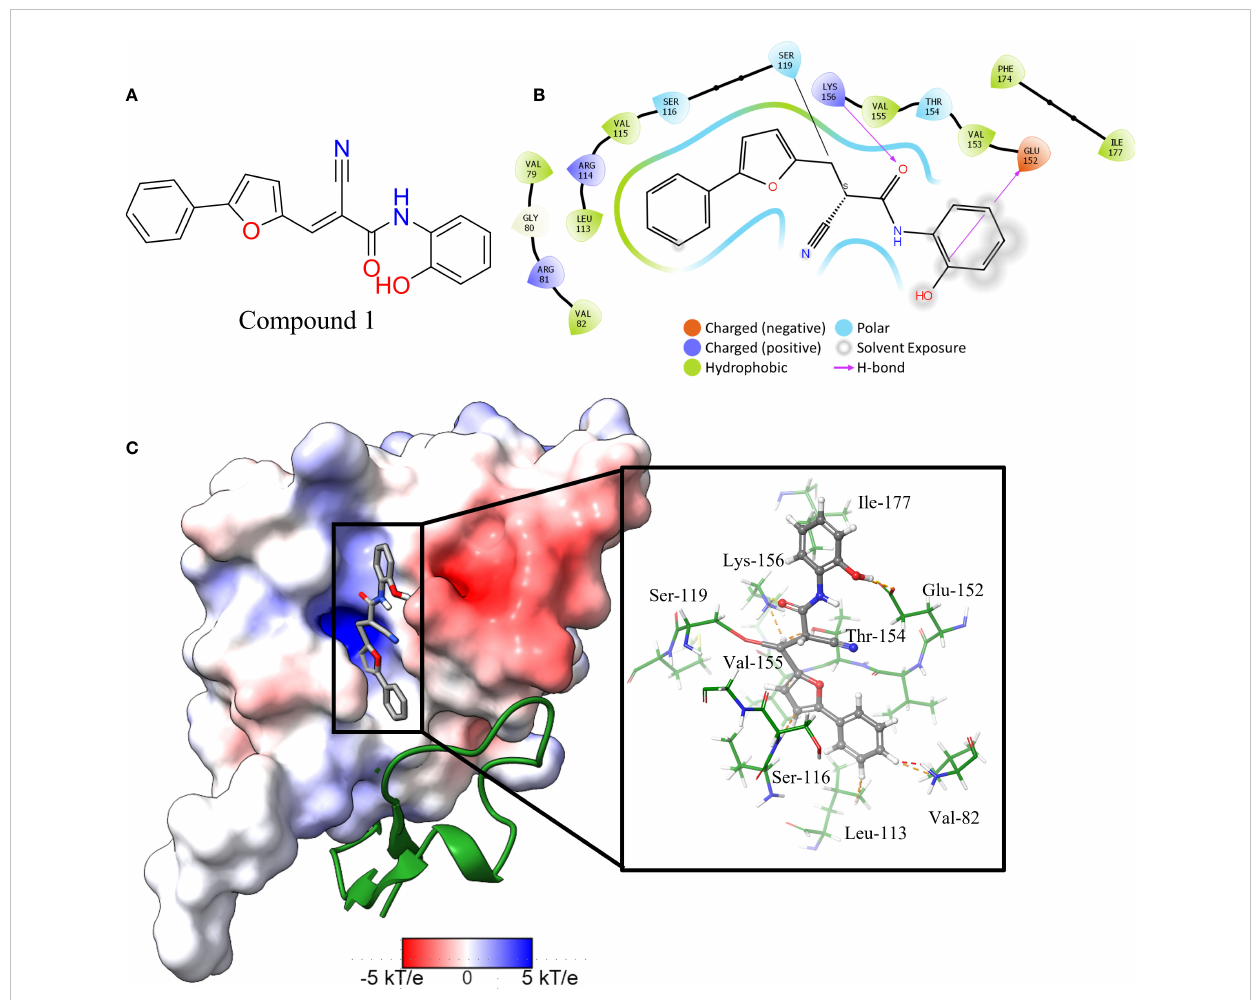
FIGURE 5 Interaction pro fi le of compound 1. (A) 2D structure of compound 1. (B) 2D representation of the amino acid residues directly interacting with the compound. Residue color is based on the type, grey atom background is the solvent-accessible surface area. (C) The full LexA CTD with the bound compound and the same electrostatic surface as in Figure 3, with the DelPhi Webserver generated electrostatic surface. The ribbon also denotes the CSR of LexA. The insert shows the 3-D orientation of the molecule with the surrounding interacting